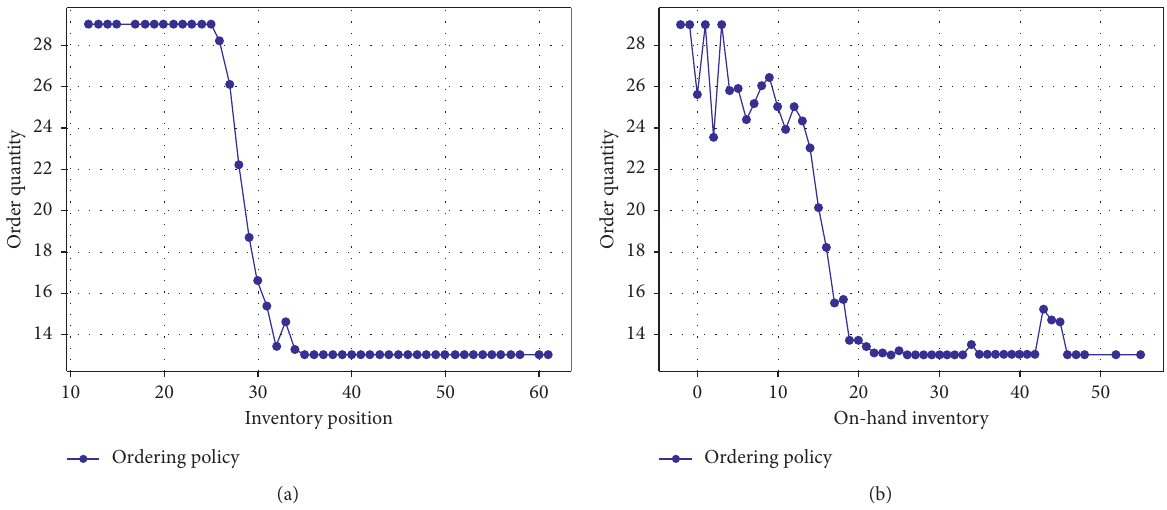
Figure 7: This statistic results are from 􏽥 p 5 , where l � 4 and L � 2. When L � 2, x it is a vector and order quantity is the mean from the same inventory value.